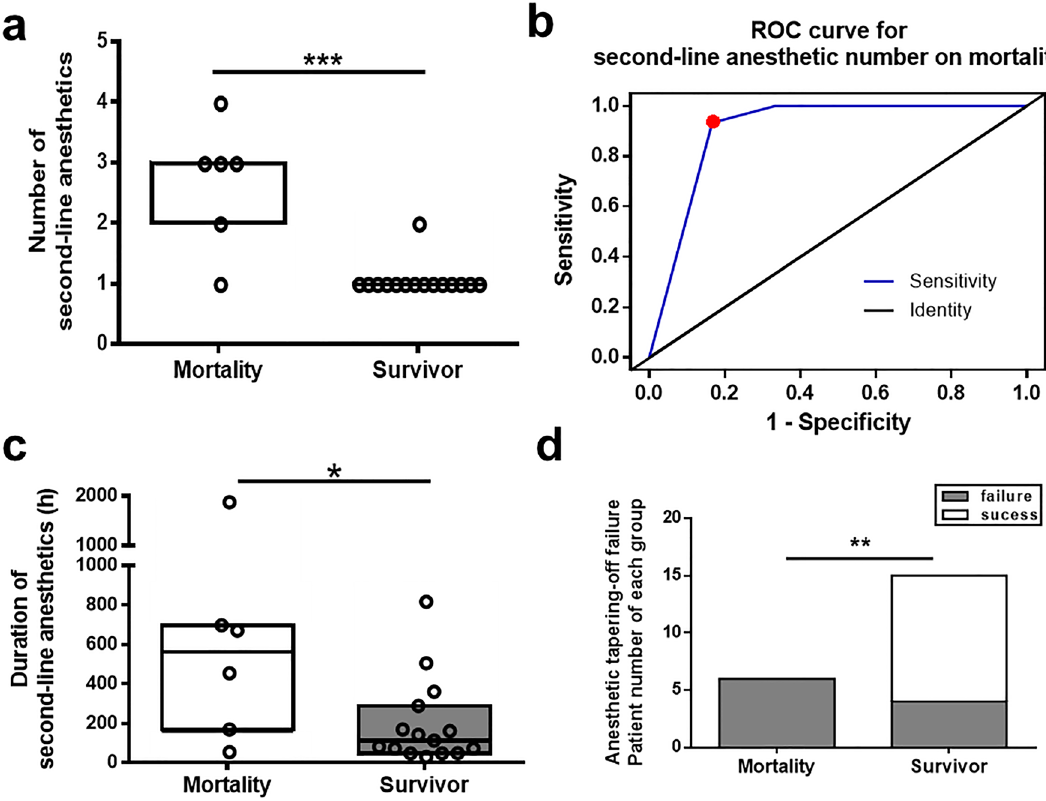
Figure 3. Second-line anesthetic use in patients with SRSE. ( a ) Numbers of second-line anesthetics used in the mortality and survival groups. ( b ) ROC curve for the number of second-line anesthetics to discriminate mortality. ( c ) Duration of second-line anesthetic use in mortality and survival groups. ( d ) Patient numbers for success or failure of tapering off anesthetics in the mortality and survival groups. * p < 0.01, ** p < 0.01, *** p < 0.01. Dark lines indicate median values, and boxes indicate interquartile ranges ( a ) and ( c ) . The red dot in ( b ) indicates the cutoff point of 1.5. SRSE super-refractory status epilepticus, ROC receiver operating characteristic.